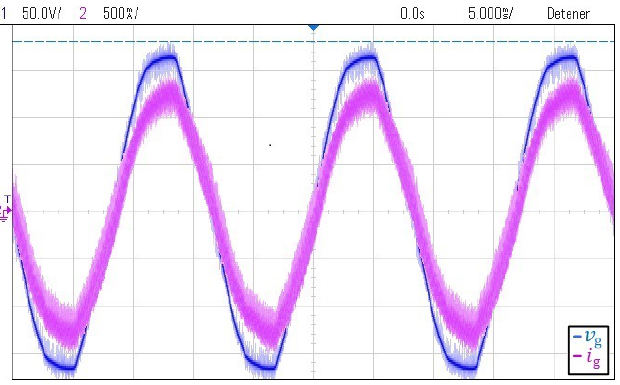
Figure 25. Waveforms of v g and i g for I s =